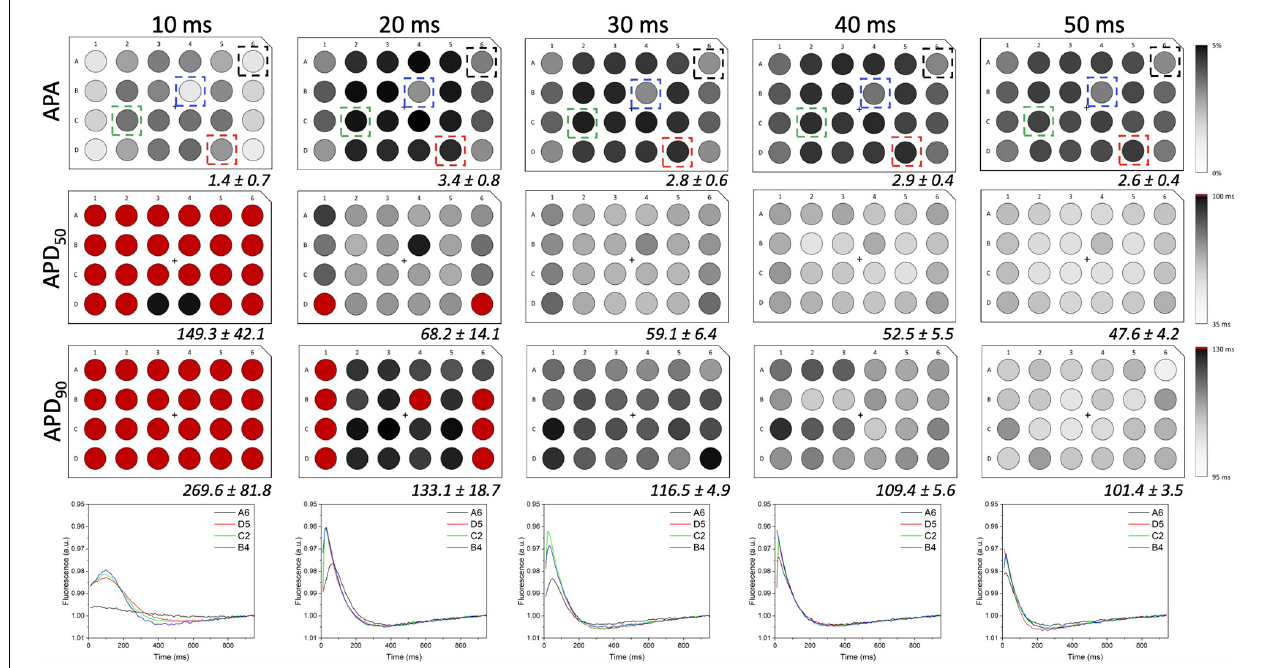
FIGURE 5 | AP kinetics versus optogenetic pulse duration. APA and AP duration (i.e., APD 50 and APD 90 ) values registered from LV-transduced HL-1 cells seeded in 24-well plates and irradiated at maximum light intensities and for the pulse durations indicated at the top of the figure (1 Hz stimulation frequency). Average ± standard deviation of APAs and AP durations were calculated for all 24 wells in the plate and for each experimental condition. Representative traces taken from wells placed at different distances from the optical axis are shown for each stimulation time. By increasing pulses duration from 10 to 50 ms, interwell differences decreased for all the AP parameters considered, thus overcoming the spatial heterogeneity induced by the simplicity of the implemented optical scheme.